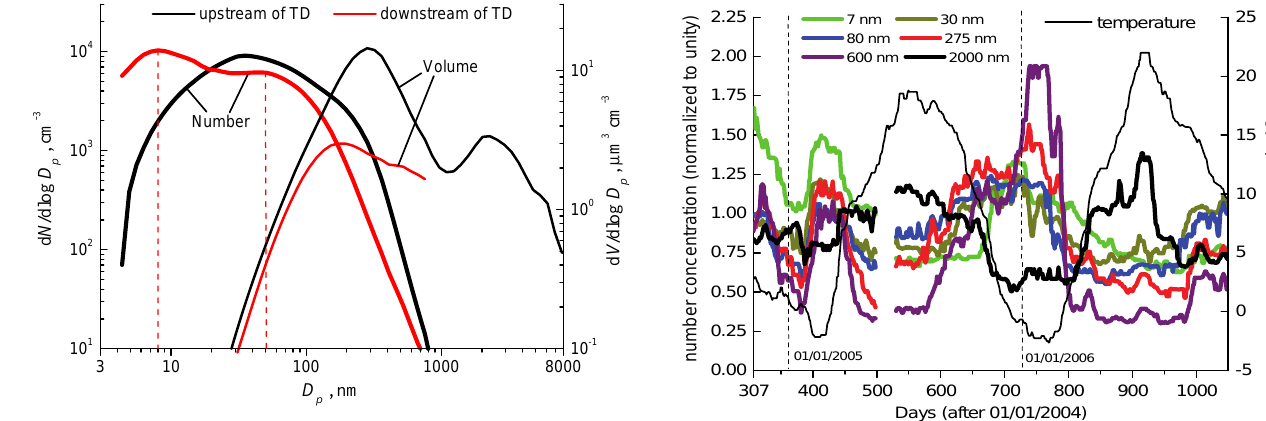
Fig. 4. Time series of particle number concentration (30-day run- ning median values) over the entire two-year period. Shown are the particle concentrations at discrete particle diameters, each nor- malised to an average of unity. Time is coded in days after 01 Jan- uary 2004. The thin line indicates ambient temperature (30-day run- ning